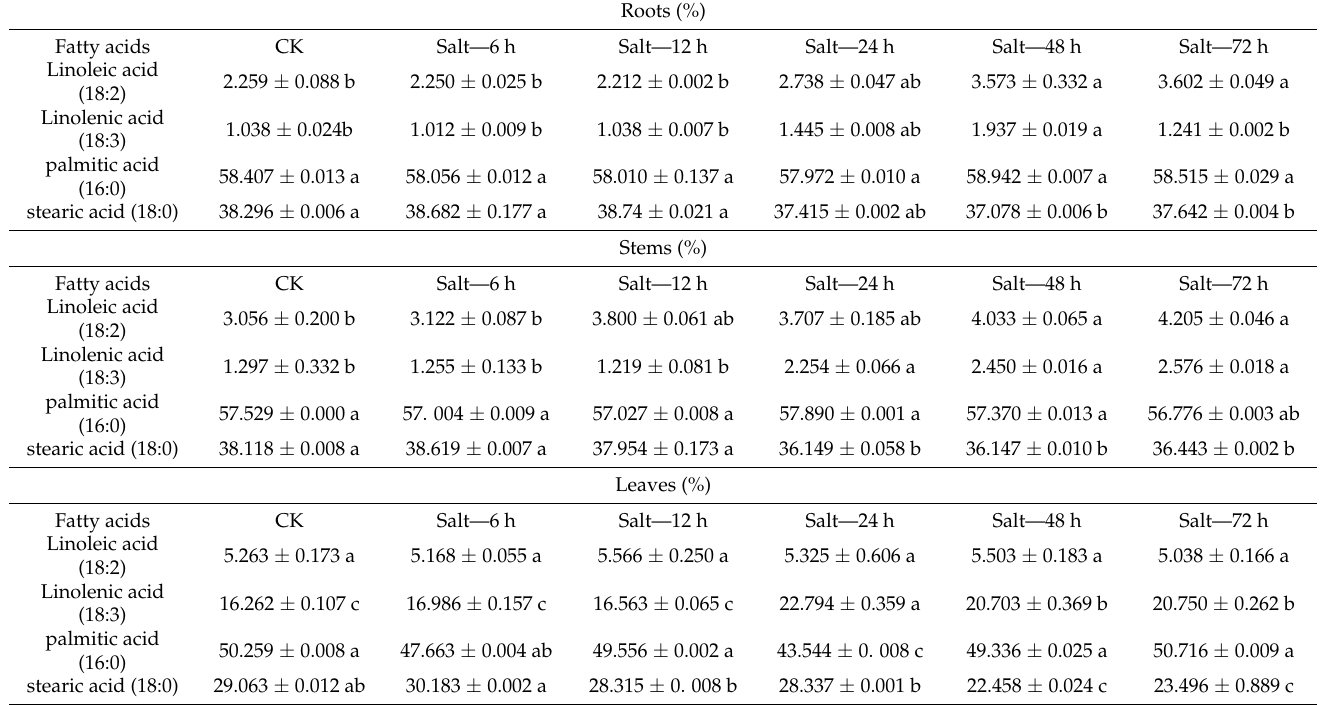
Table 2. Effect of salt on the compositions and contents of fatty acids in safflower different